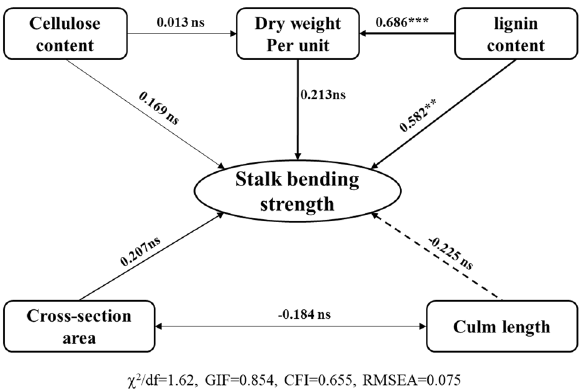
Figure 6. Path analysis of SBS, stem morphology and structural carbohydrates